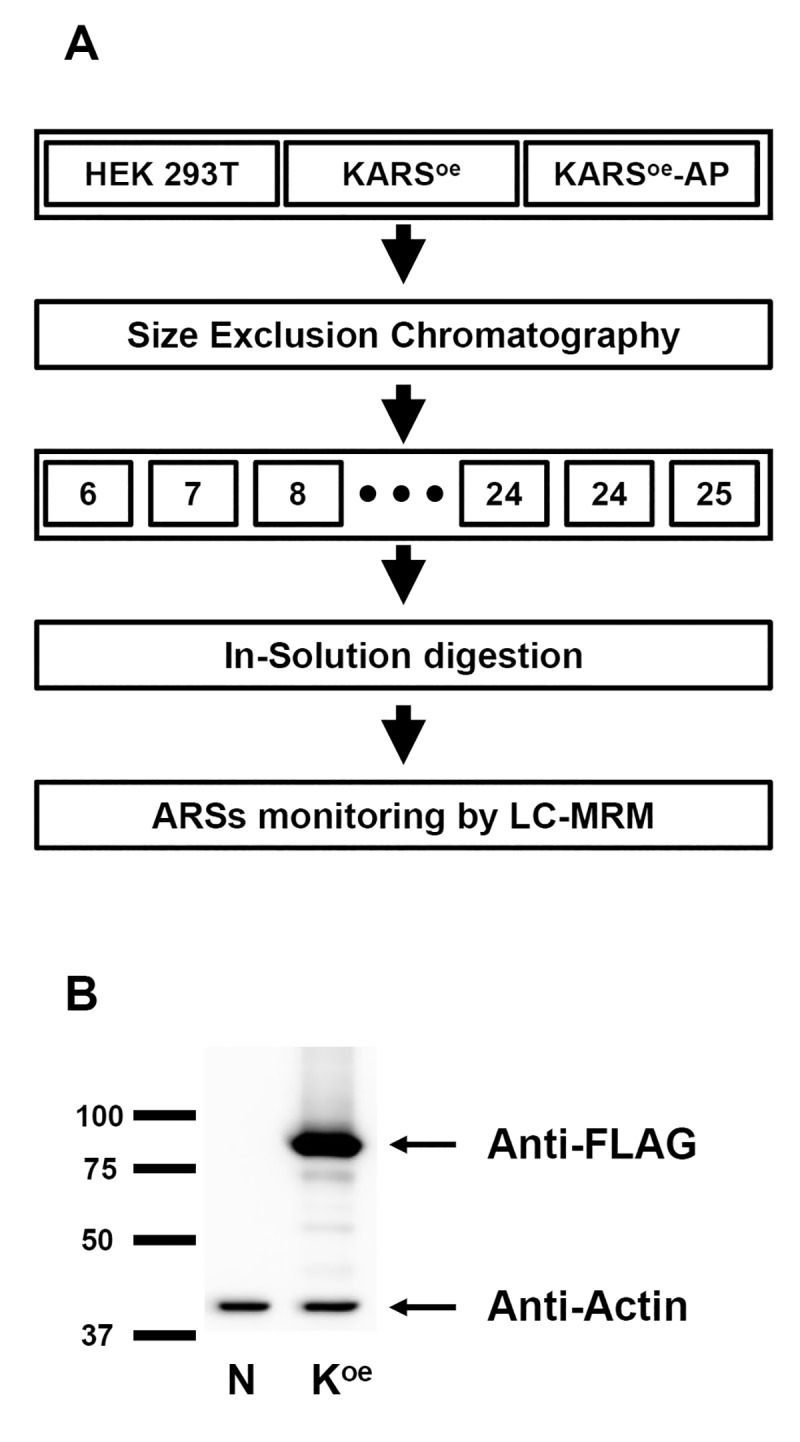
Overall workflow for detection of ARS proteins.
(A) Overall workflow. Two cell lysates (HEK 293T and KARSoe) and affinity purification eluate (KARSoe-AP) were fractionated using SEC. Each fraction was digested with trypsin and spiked with the SIS peptide. After C18 clean-up, the digest was analyzed by LC-MRM-MS. All the data were analyzed by Skyline. (B) Overexpression of KARS tagged with S/FLAG/SBP in HEK 293T cell was detected by western blot using anti-FLAG antibody. Actin was used as a loading control. N, HEK 293T cell; Koe, KARS-overexpressing cell.